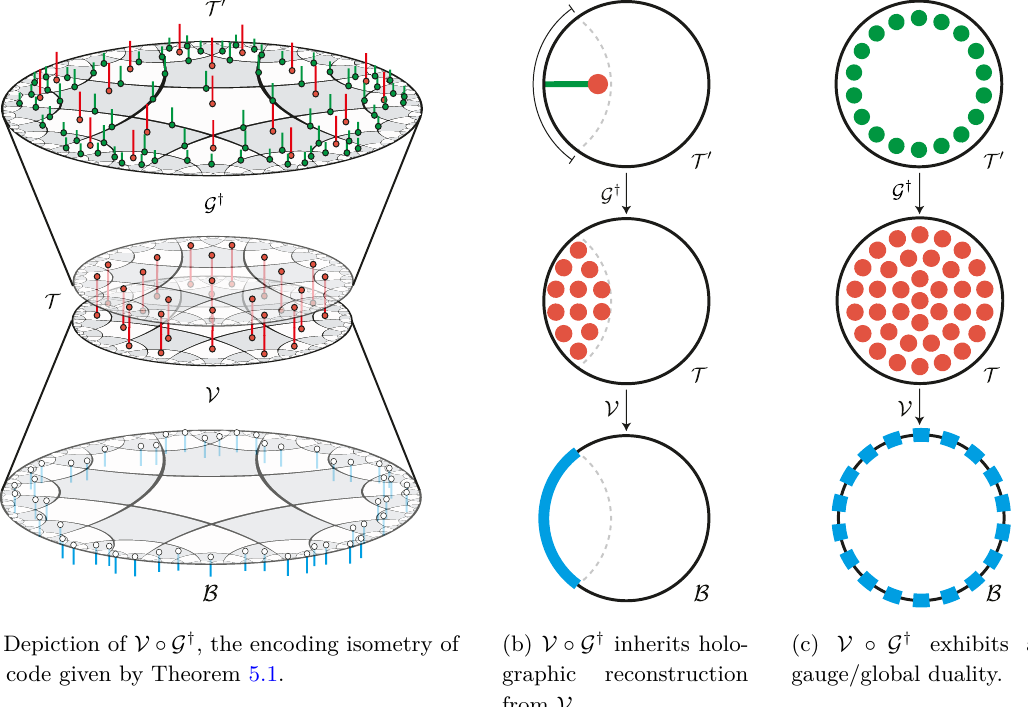
Figure 11. Basic components of the proof that any holographic code with a global/global symmetry duality can be converted into one with a gauge/global symmetry duality via Theorem 5.1. (a) The encoding isometry of the new code is constructed by composing the Hermitian conjugate of the gauging map with the encoding isometry of the given code, i.e. V 0 = G † ◦ V . Each map is depicted in tensor network notation with their legs arranged to reflect the locality of the degrees of freedom they represent. The composition is depicted by the contraction of legs in the T system. Red lines represent Bulk vertex degrees of freedom, green lines represent Bulk edge degrees of freedom, and blue lines represent the Boundary degrees of freedom. (b) V ◦ G † inherits the code properties of V because T 0 operators (red dot with green line) in the entanglement wedge of a region can be implemented by T operators (many red dots left of dashed line) which have support in the same wedge, which in turn can be reconstructed on the Boundary region (blue arc) using the original code. The thin black line shows the Boundary region and the dashed line its entanglement wedge. (c) V ◦ G † exhibits a gauge/global duality because an asymptotic symmetry transformation (green dots) on T 0 is implemented as a global symmetry transformation (red dots) on T , which is in turn implemented by a global symmetry transformation on the Boundary (blue